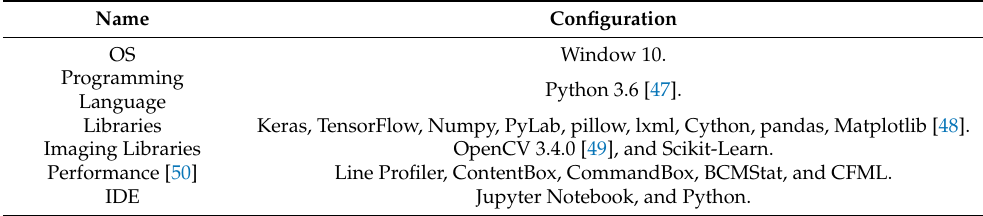
Table 2. Software specifications for model